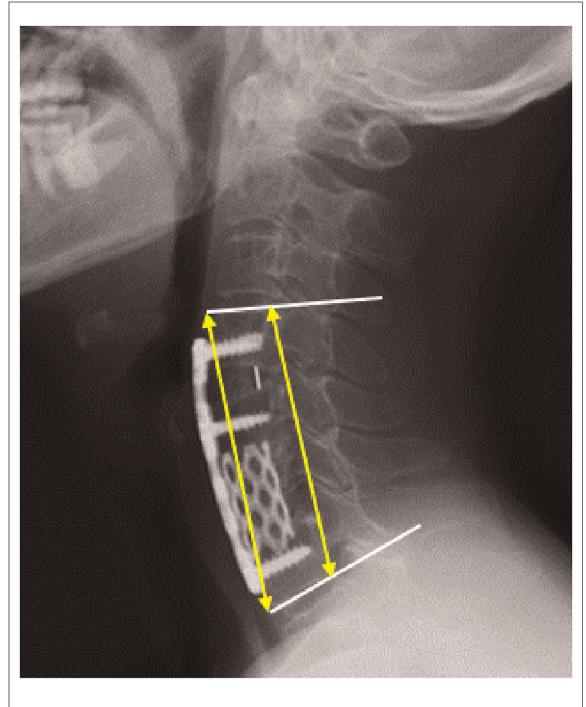
FIGURE 3 The height of the anterior column (the mean value of two yellow arrows) and the cobb angle of fusion segments (the angle of two white lines). FIGURE 4